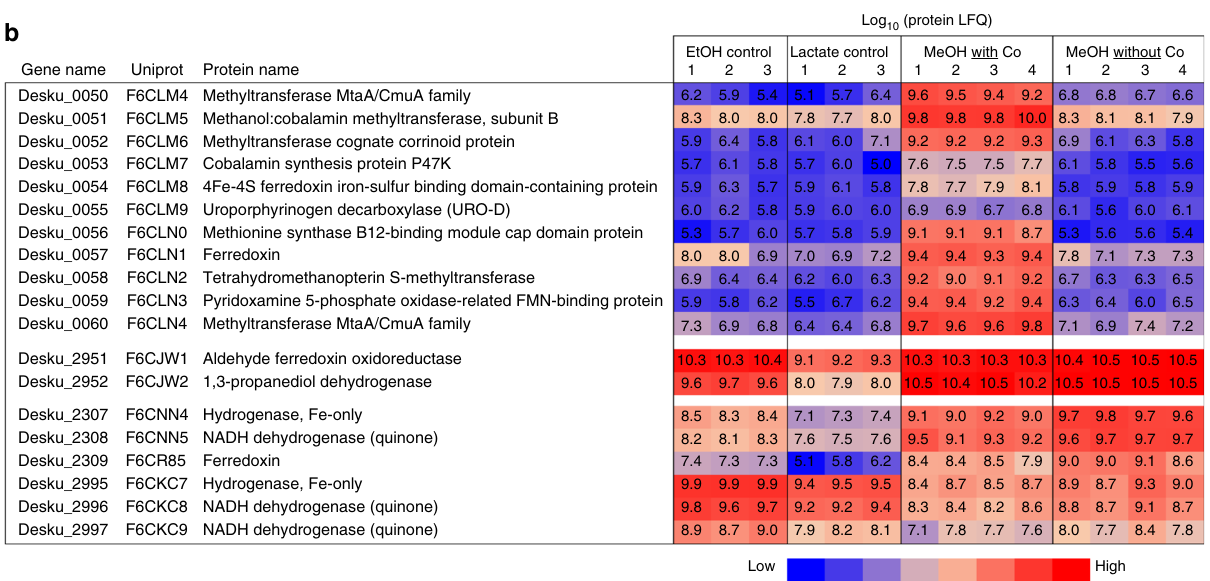
Fig. 1 Comparative proteomics results. a Volcano plot with comparison of cells grown on 20 mM methanol with and without supplementation of cobalt and vitamin B12. Data are from four independent replicates (Supplementary Data 1). b Identi fi cation of the predicted function of proteins depicted in the volcano plot and corresponding label-free quanti fi cation (LFQ) values for proteins quanti fi ed in cells grown with different electron donors (20 mM ethanol, 20 mM ethanol, 20 mM methanol with and without supplementation of cobalt, and vitamin